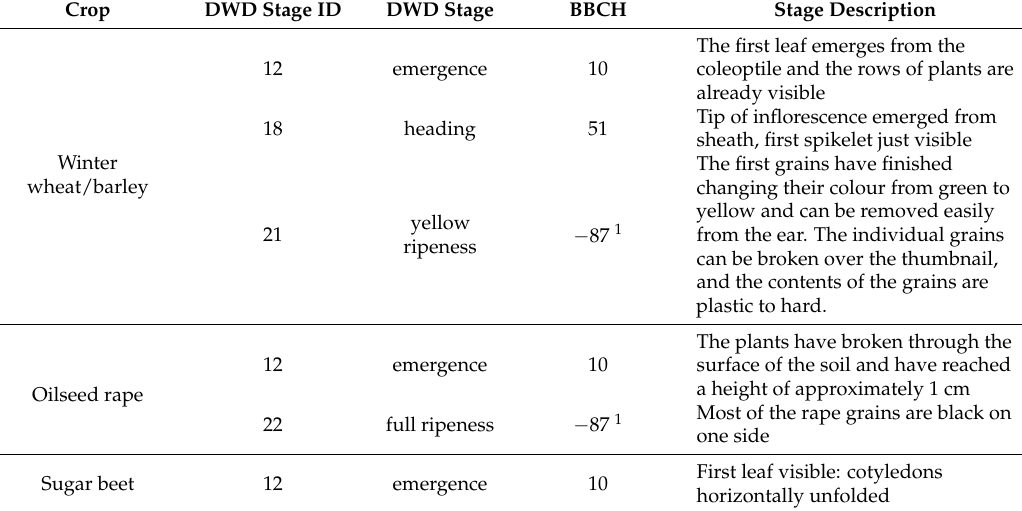
Table 1. Targeted phenostages of different major crops in this study based on DWD and B iologische B undesanstalt für Land- und Forstwirtschaft, Bundessortenamt und CH emische Industrie (BBCH) scale